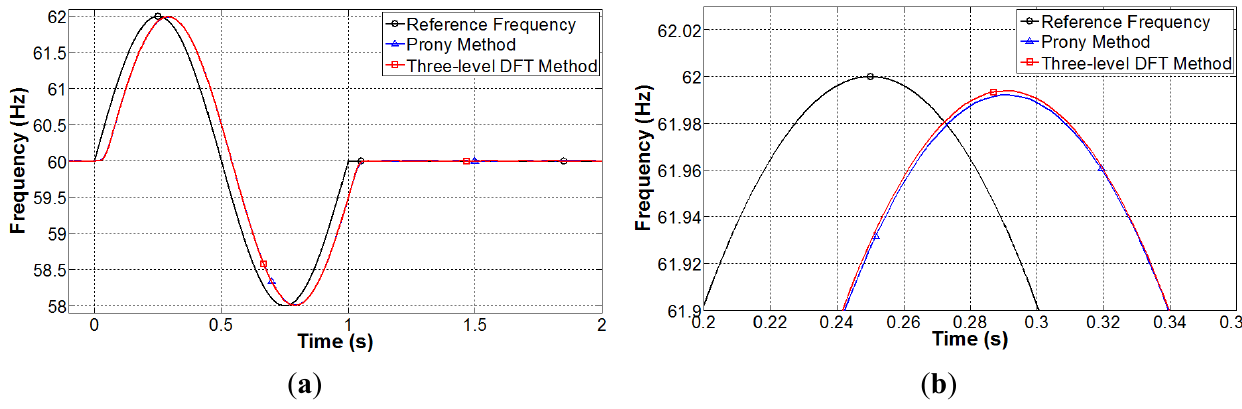
Figure 3. Estimation of a sinusoidal frequency variation. ( a ) Estimated frequency; ( b ) Close-up of the